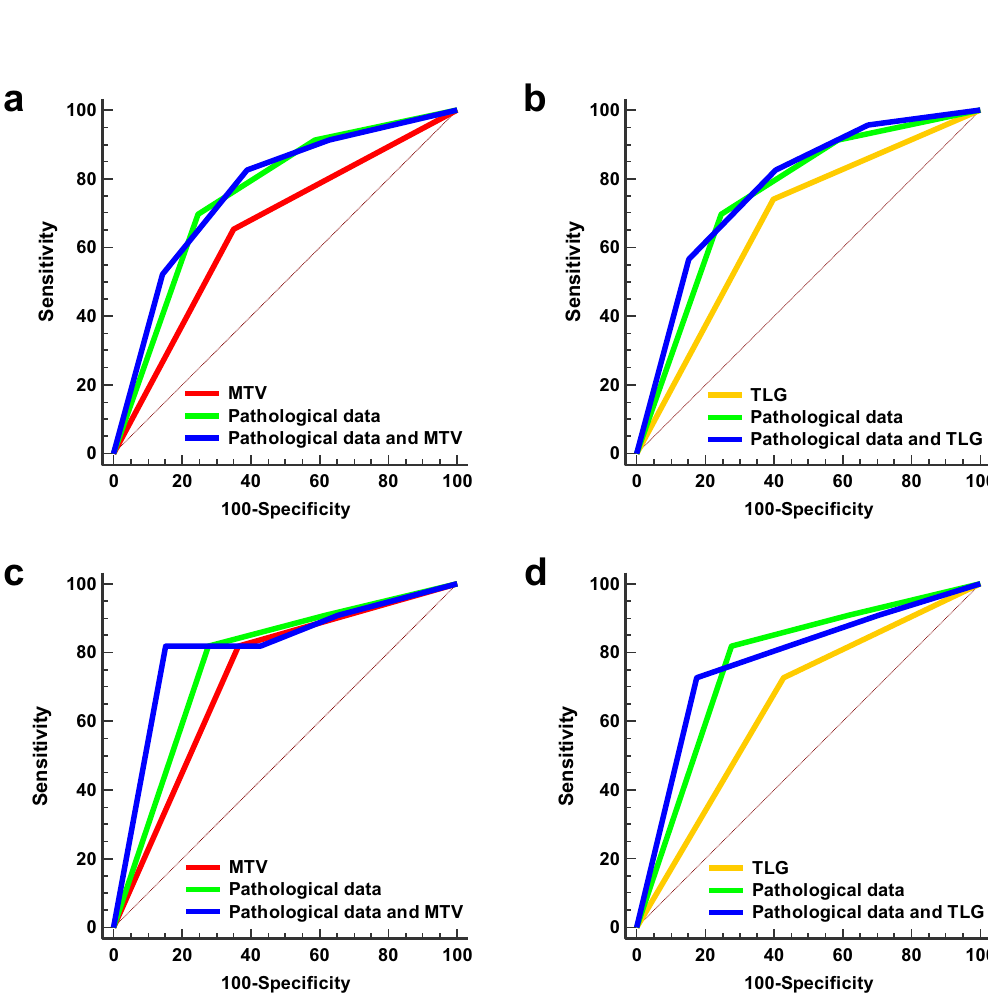
Figure 3. ROC curve analysis of metabolic tumour volume (MTV), total lesion glycolysis (TLG), pathological factor (with pTstage/LN metastasis), model 1 (with pTstage/LN metastasis and MTV), and model 2 (with pTstage/LN metastasis and TLG) for predicting disease-free survival (DFS) and overall survival (OS). Receiving operating characteristic curve analysis showed no additional value of MTV ( a ) and TLG ( b ) to pathologic factor (primary T stage and lymph node metastasis) for predicting DFS. For predicting OS, there was a significant additional value of MTV ( c ), but no additional value of TLG to pathologic factor ( d